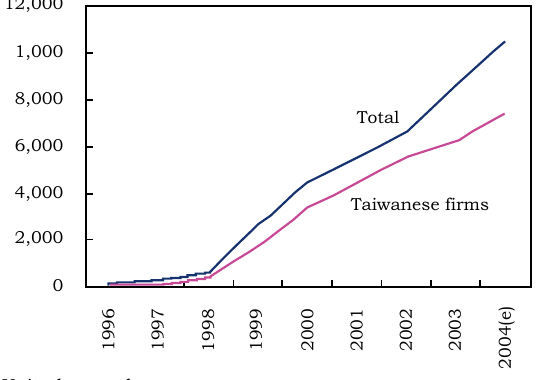
Figure 2. Shipment of CD-R Source: Estimated from multiple datasource. Taiwanese data mainly estimated from IEK data and other countries from